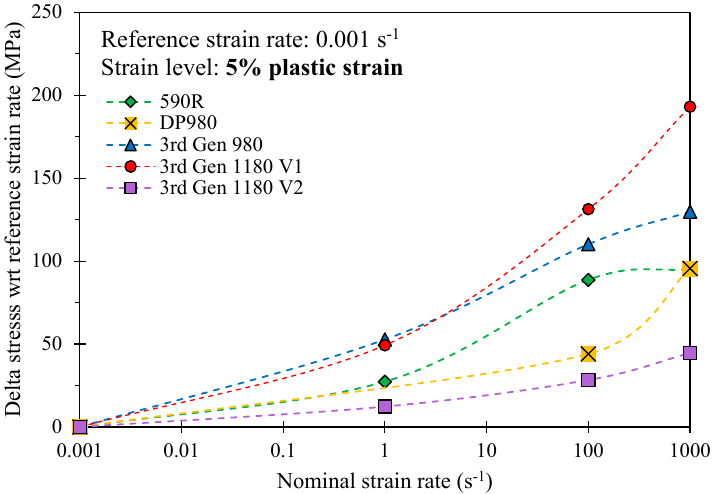
Figure 14. Comparison of the strain-rate induced increase in the flow stress at higher strain rates with respect to the stress level at the reference strain rate of 0.001 s − 1 at a plastic strain of 5% for one representative repeat.